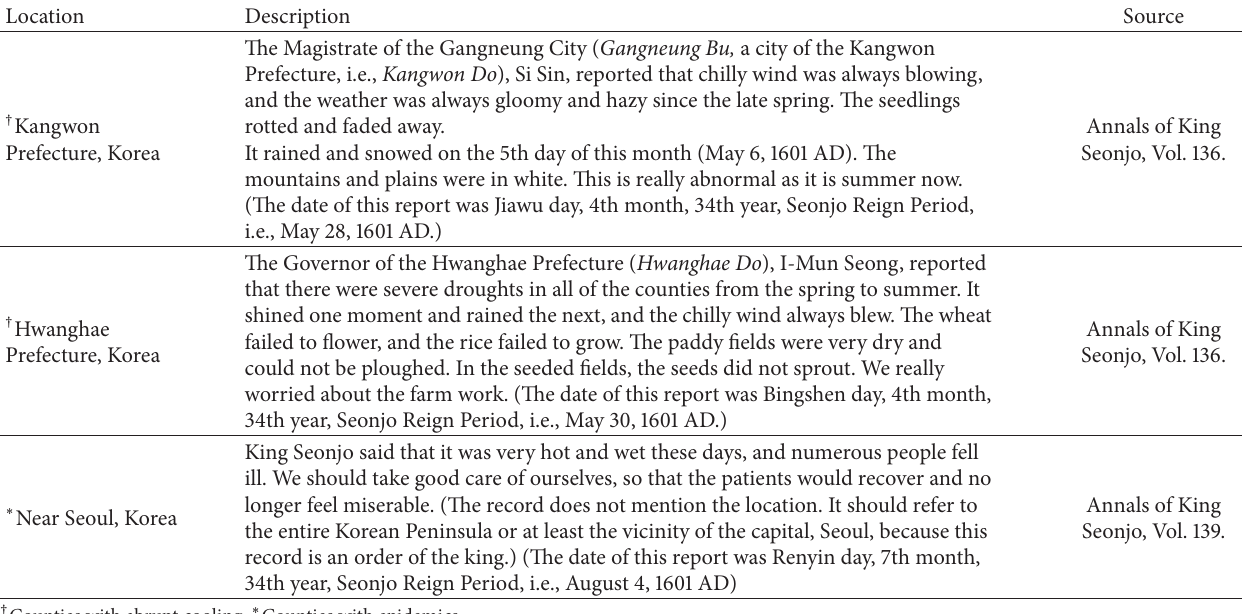
Table 3: Historical records of the abrupt cooling and epidemics in Korea in 1601 AD.